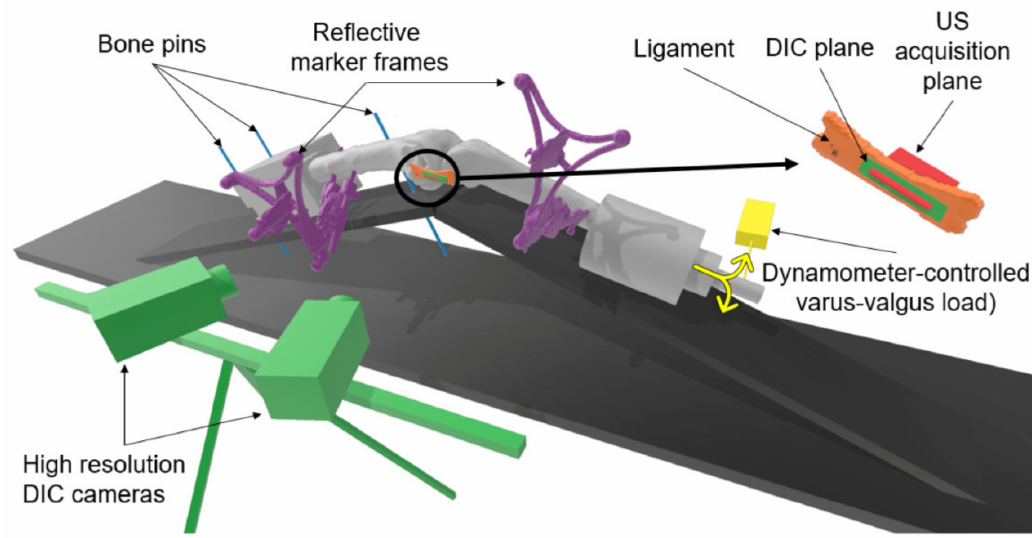
Figure 1. Experimental setup. Legs were positioned with a constant flexion–extension angle of 30 ◦ . The femur was rigidly attached using bone pins ( blue ), while the tibia was free to move and rotate relative to the femur to performed dynamometer-controlled varus–valgus loading ( yellow ). Rigid marker frames containing four reflective spheres each were pinned on the femur and the tibia ( purple ). High-resolution digital image correlation (DIC) cameras were placed to measure the strains on the ligament surface ( green ). An ultrasound probe was aligned in parallel with the longitudinal direction of the ligament ( orange ), centered on the joint line ( red